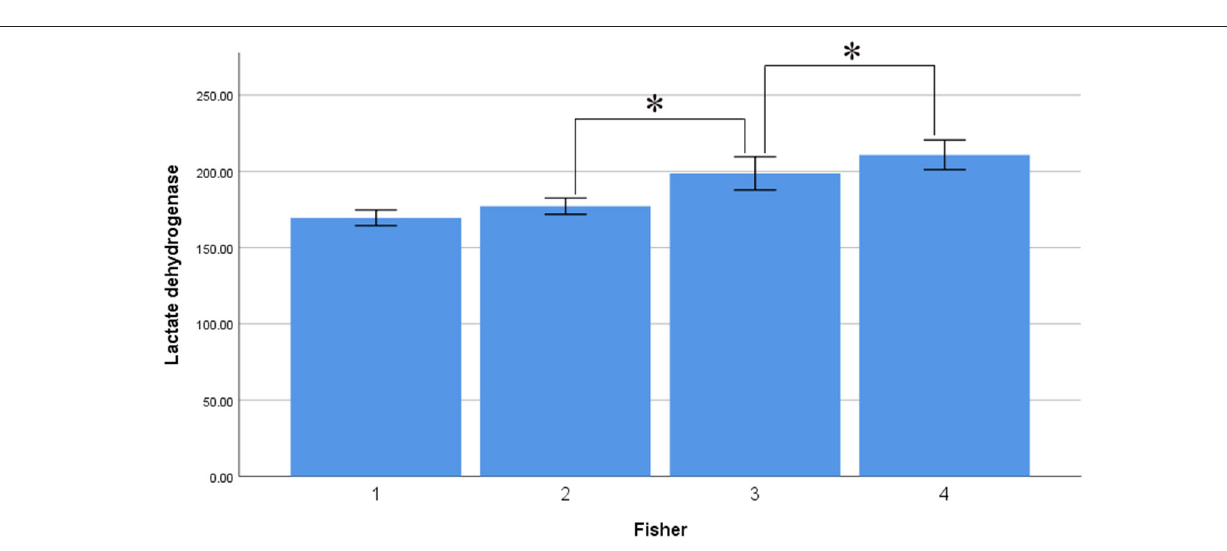
FIGURE 4 | Average level of serum LDH in different fisher grade (asterisk represent statistically significant